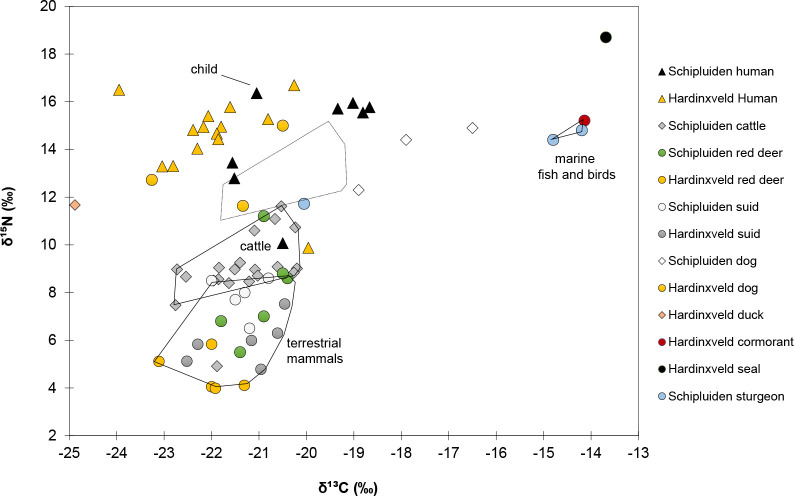
δ13C and δ15N values of bone collagen from Schipluiden fauna (this study), humans (n = 8), De Bruin, and Polderweg (Hardinxvel humans n = 14, fauna n = 14)).Data from [24,25].